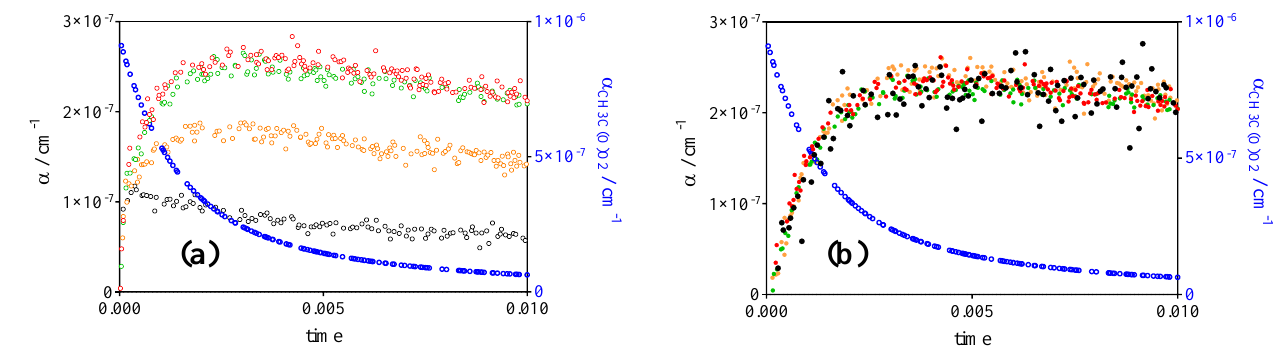
Figure 5. Absorption signals from Figure 3 for 4 different wavelengths: the signals at the three peak wavelengths are in colour, an example for the offline (magenta in Figure 3a) is shown in black. ( a ) Raw signals (open symbols), ( b ) signals obtained after subtracting 0.13 × α CH3C(O)O2 and subsequent multiplication with 1, 1.02, 1.6 and 4.1 for the red, green, orange and black circles, respectively. Blue circles are α CH3C(O)O2 (right y -axis applies).